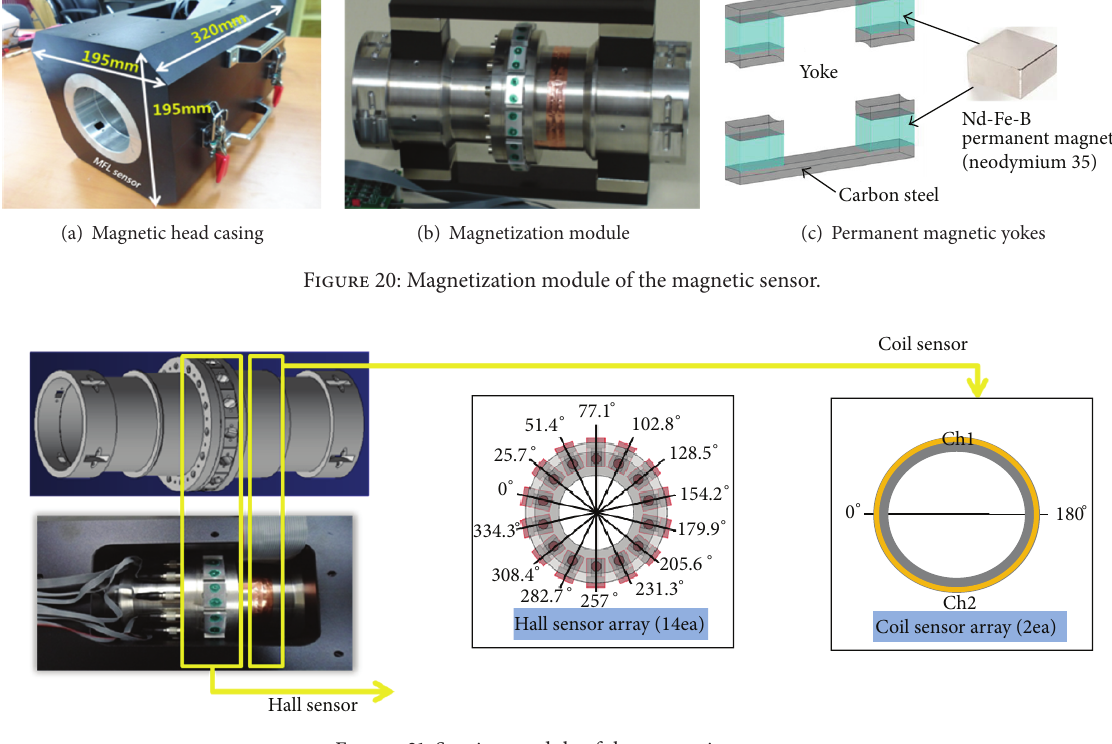
Figure 21: Sensing module of the magnetic